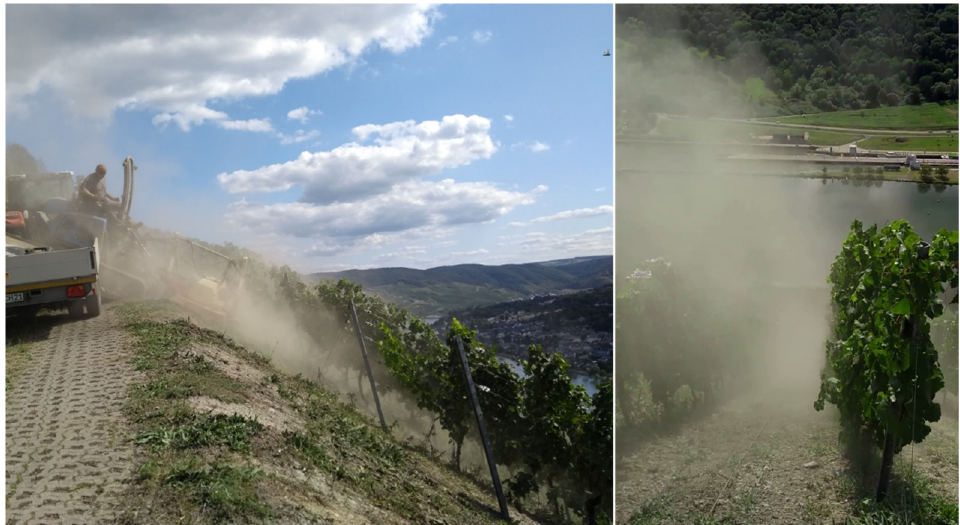
Figure 1. Dust emissions during a cultivation procedure accompanied by thermals. The tillage device has just arrived back at the top slope, the dust is following the slope-parallel ascending air.